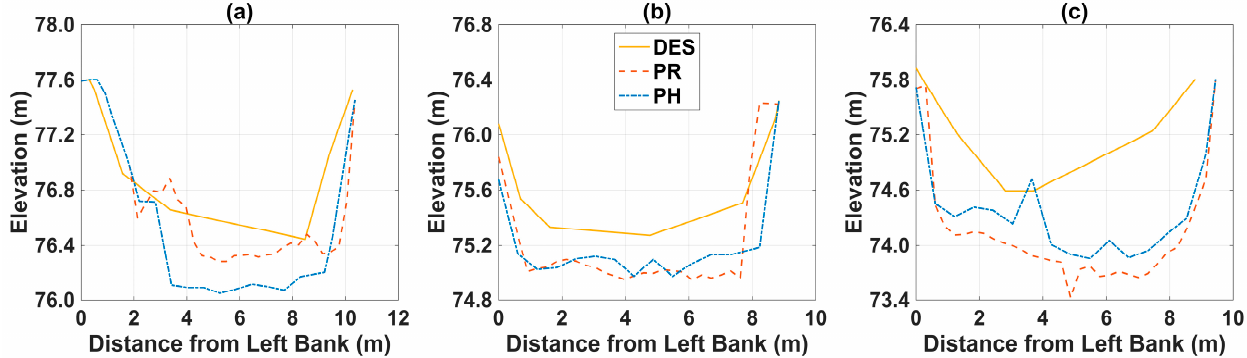
Figure 2. Comparison among the Design (DES), Post-Restoration (PR), and Post-Hurricane (PH) geometries at cross-sections ( a ) XS #4, ( b ) XS #7, and ( c ) XS #8.